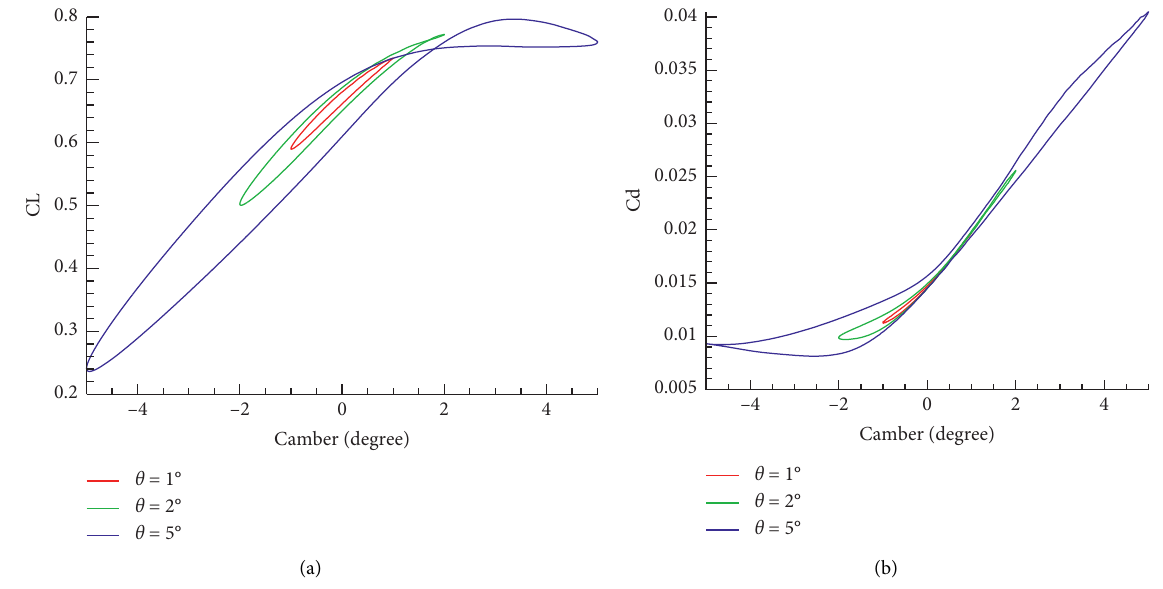
Figure 12: Influence of the extent of camber deformation on aerodynamics ( M � 0.74 , α � 2 ° , and f � 1HZ,